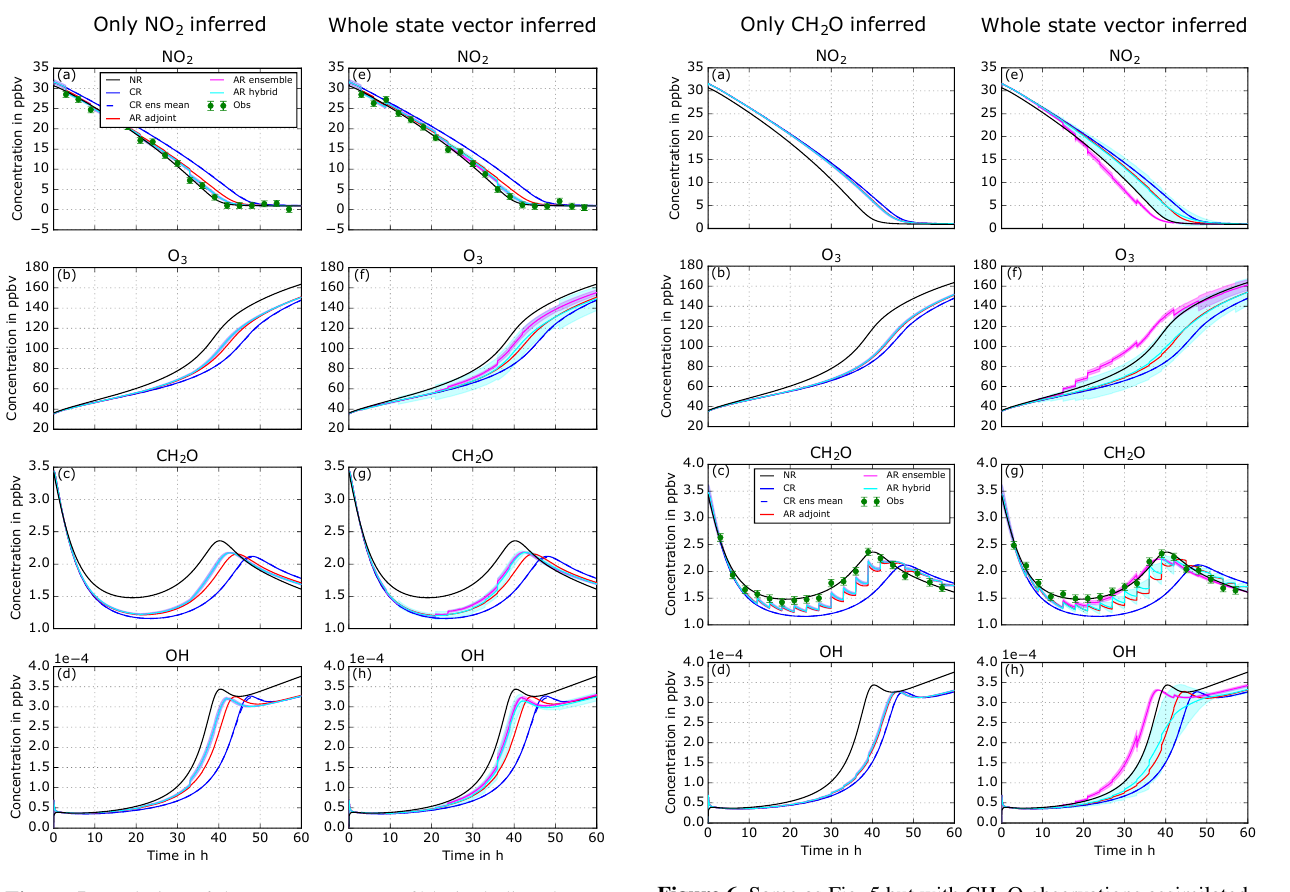
Figure 5. Evolution of the state vector over 60h, including the na- ture run (NR, black line), control run (CR, blue), and assimilation runs using adjoint (red), ensemble (pink), and hybrid (turquoise) methods. Two experiments with different localizations are dis- played: only NO 2 inferred (a–d) and whole state vector inferred (e– h) . Shaded areas show corresponding ensemble spread for ensemble and hybrid methods.